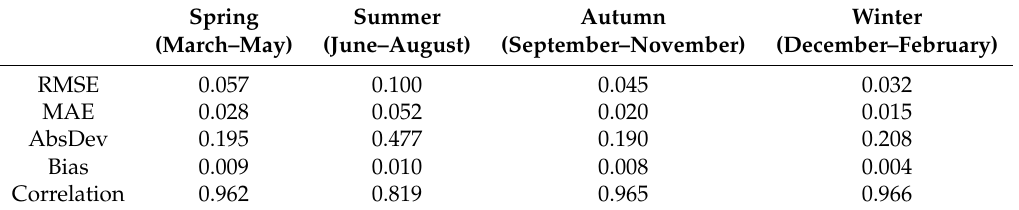
Table 8. Seasonal forecast performance of the DNN